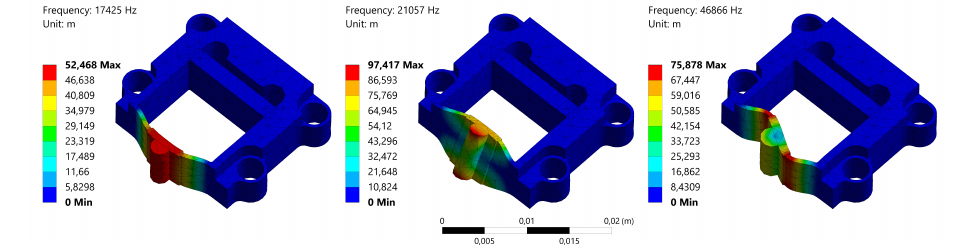
Figure 3. Static analysis results of the flexible structure. ( a ) Deformation of the hinges in the actuating direction; ( b ) Distribution of the equivalent stress; ( c ) Distribution of the safety factor.